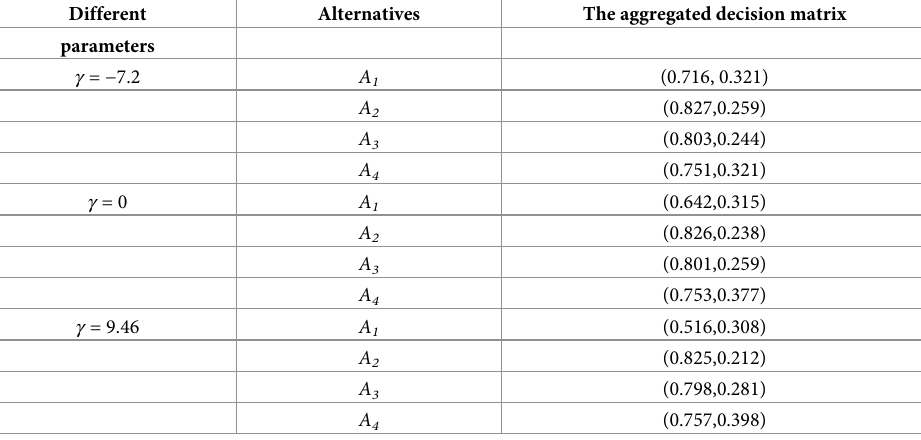
Table 5. Three individual weighted (on attributes and DMs) decision